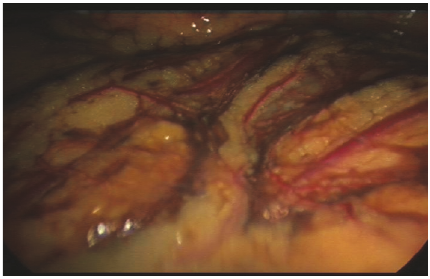
Figure 2: Intraoperative images of widespread endometriotic deposits , suggestive of leaking